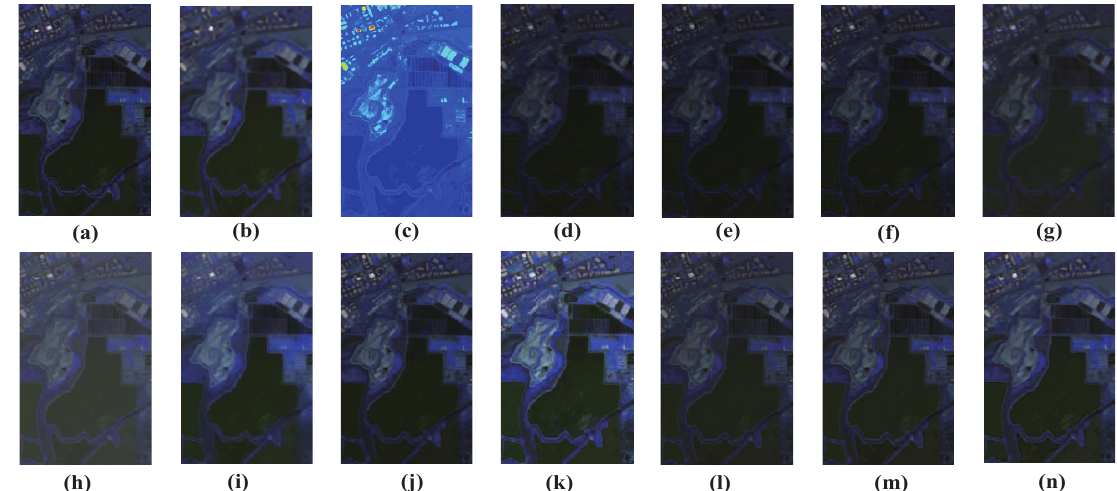
Figure 5. Visual results obtained by different methods on the Moffett data set: ( a ) ground truth, ( b ) up-sampled HSI, ( c ) PAN, ( d ) SFIM, ( e ) MTF-GLP, ( f ) MTF-GLP-HPM, ( g ) GS, ( h ) GSA, ( i ) GFPCA, ( j ) CNMF, ( k ) Lanaras’s, ( l ) FUSE, ( m ) HySure, and ( n ) SCAAE. Note that the false color image is chosen for clear visualization (red: 10, green: 30, and blue: